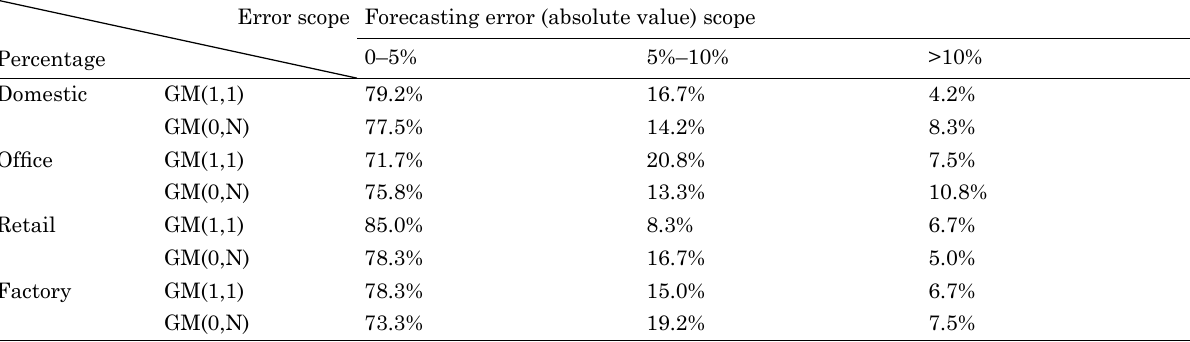
Table 3. Statistics of forecasting performance of two grey models (Jan 2005–Dec